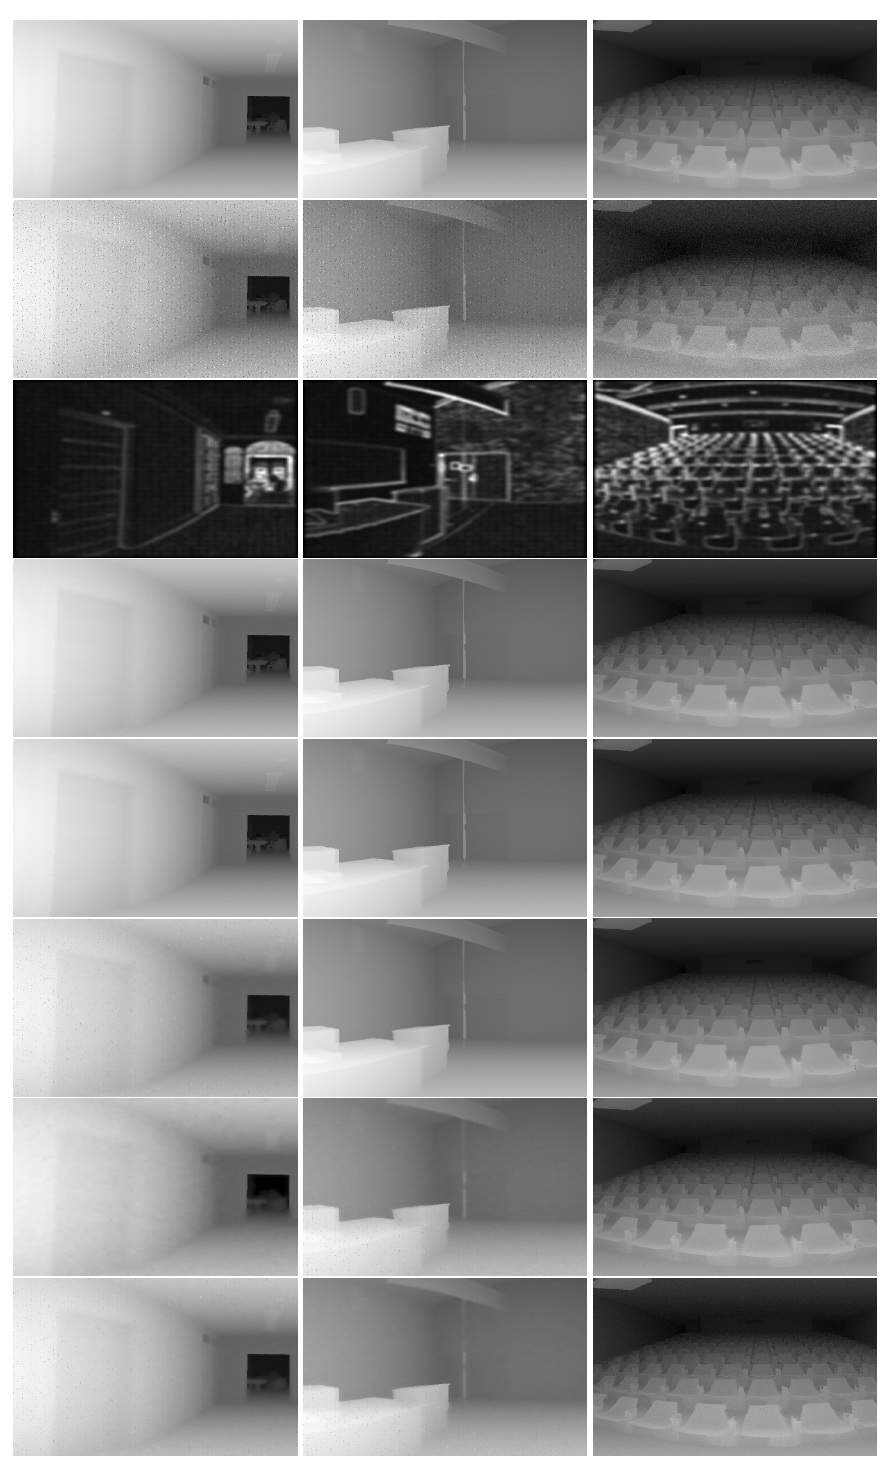
Figure 5. Results of denoising experiments on real data (see online version for details). The original and noisy corrupted range images are shown in the first and second rows, respectively. The third row depicts our intermediate results of informative level estimation. Rows 4 to 8 depict the results of Our-BOMP , Our-LASSO , Adaptive SC , Basic SC , and Trilateral filter ,